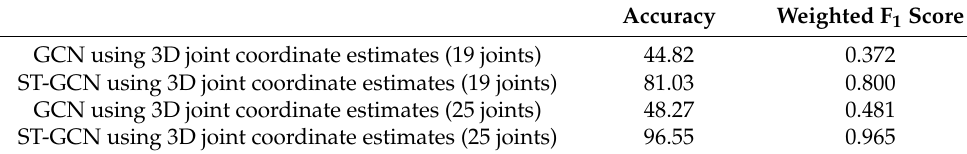
Table 4. Comparison of 3D human joint coordinate estimates on the MMActivity dataset